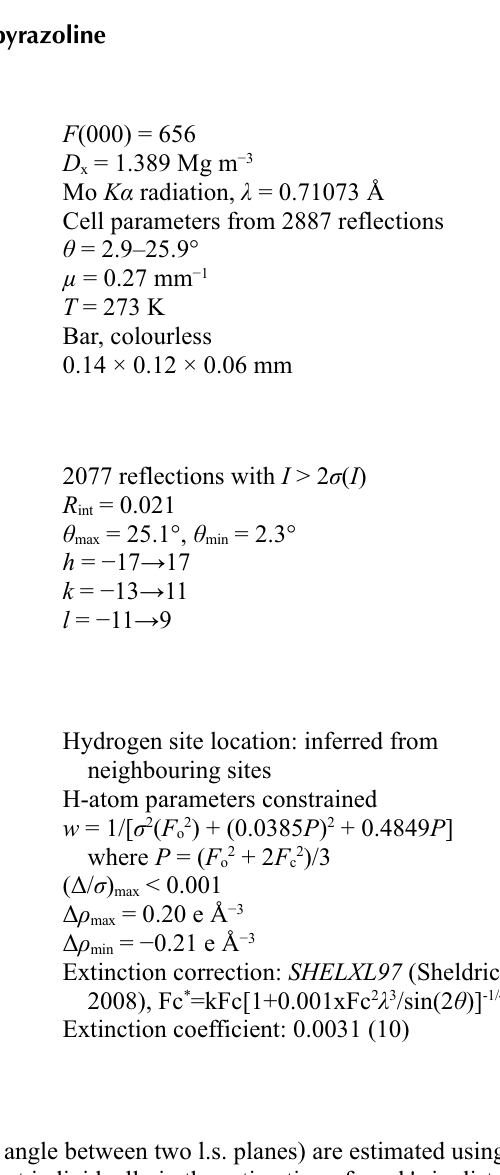
Figure 2 View of the crysytal packing of (I) in the unit